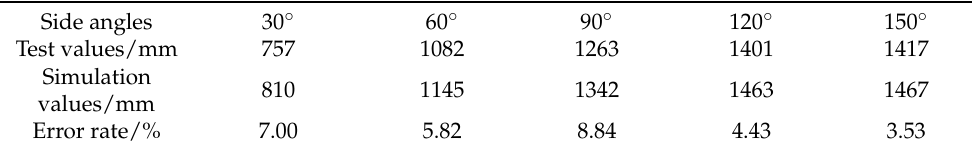
Table 2. Comparison of simulation and field test results.